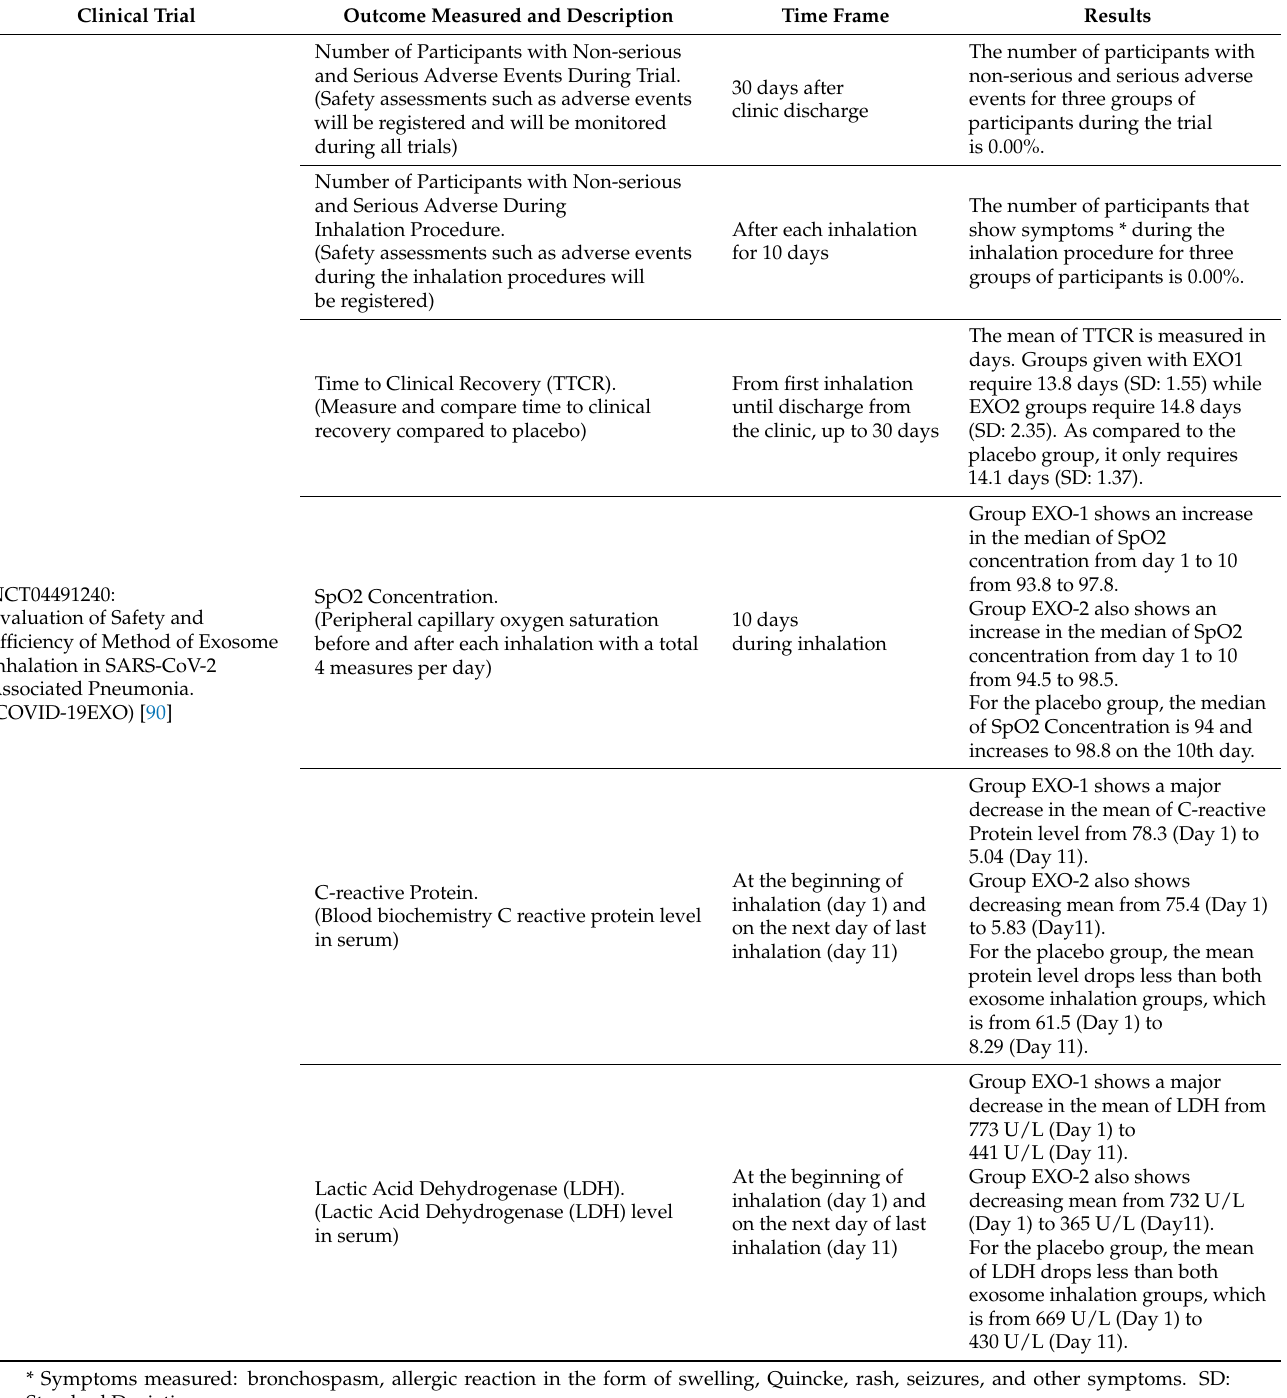
Table 6. Summary of the results of clinical trial NCT04491240 based on their outcome measured. Clinical Trial Outcome Measured and Description Time Frame